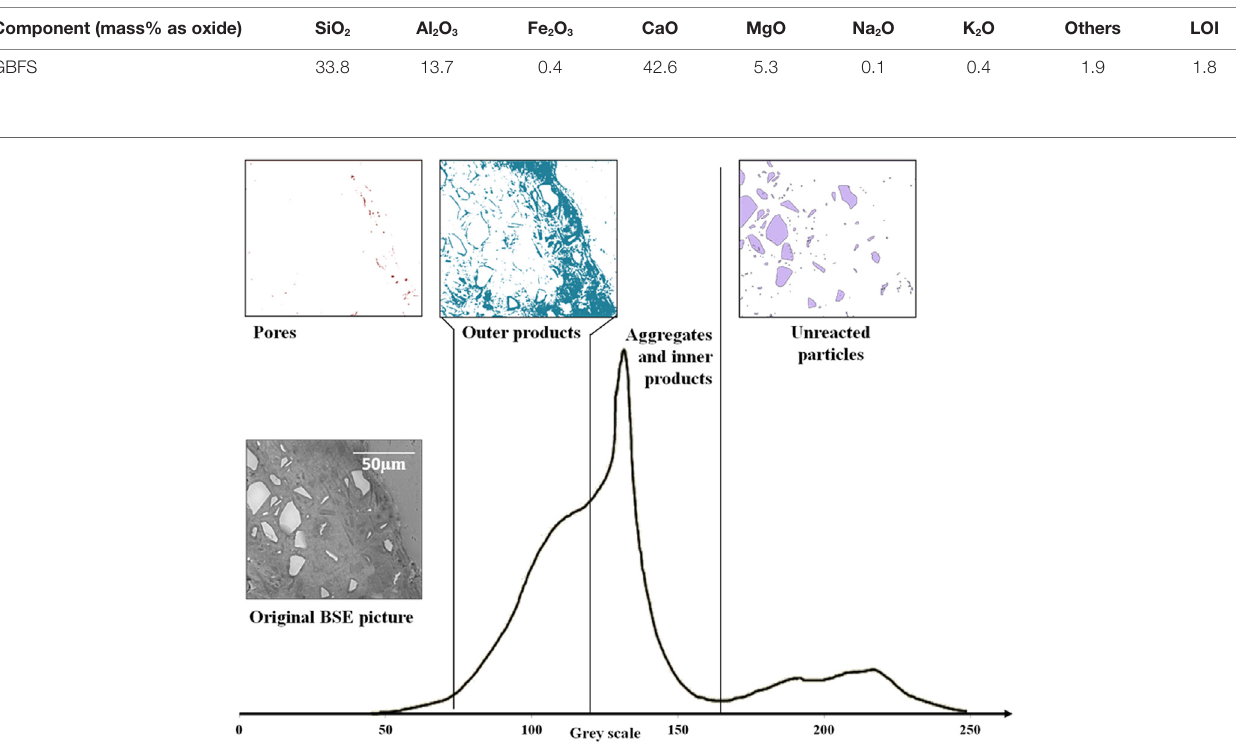
FigUre 1 | Typical gray level histogram of an alkali-activated slag mortar, plus binary images of different phases . From the left (darkest gray level), the first shoulder corresponds to porosity, the second shoulder is the outer products of slag reaction, the middle peak is associated with reacted material and aggregates, and the rightmost peak is associated with unreacted